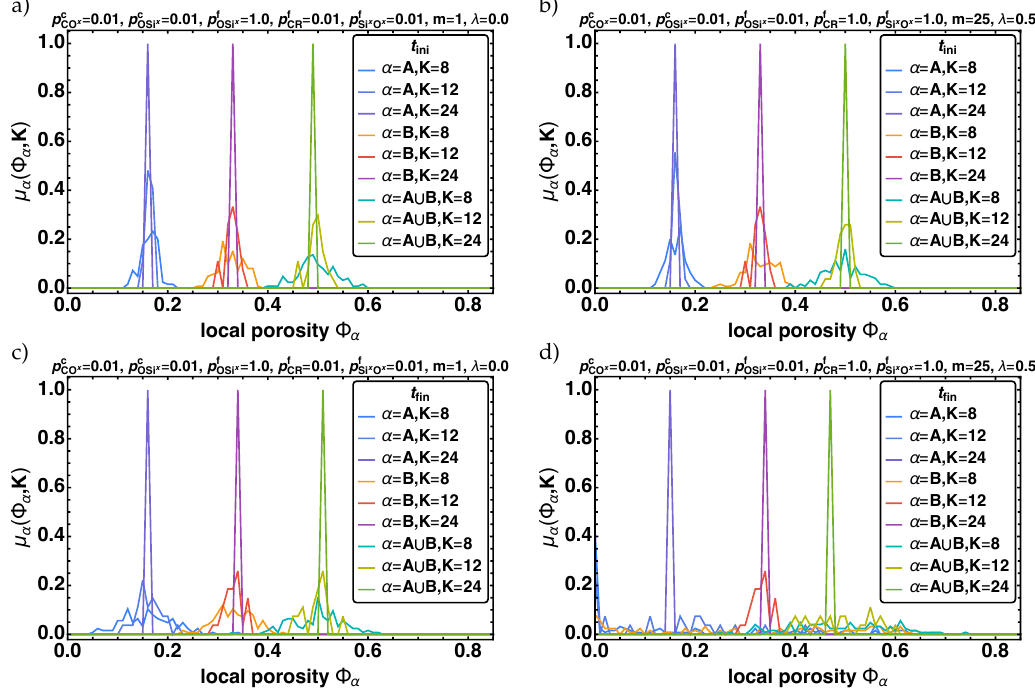
Figure 10. The local porosity distributions µ α ( Φ α , K ) for K = { 8,12,24 } and α = { A, B, A ∪ B } are given over the local porosity Φ α for the two parameter combinations (I) and (II). In ( a , b ) the initial and in ( c , d ) the final distributions are